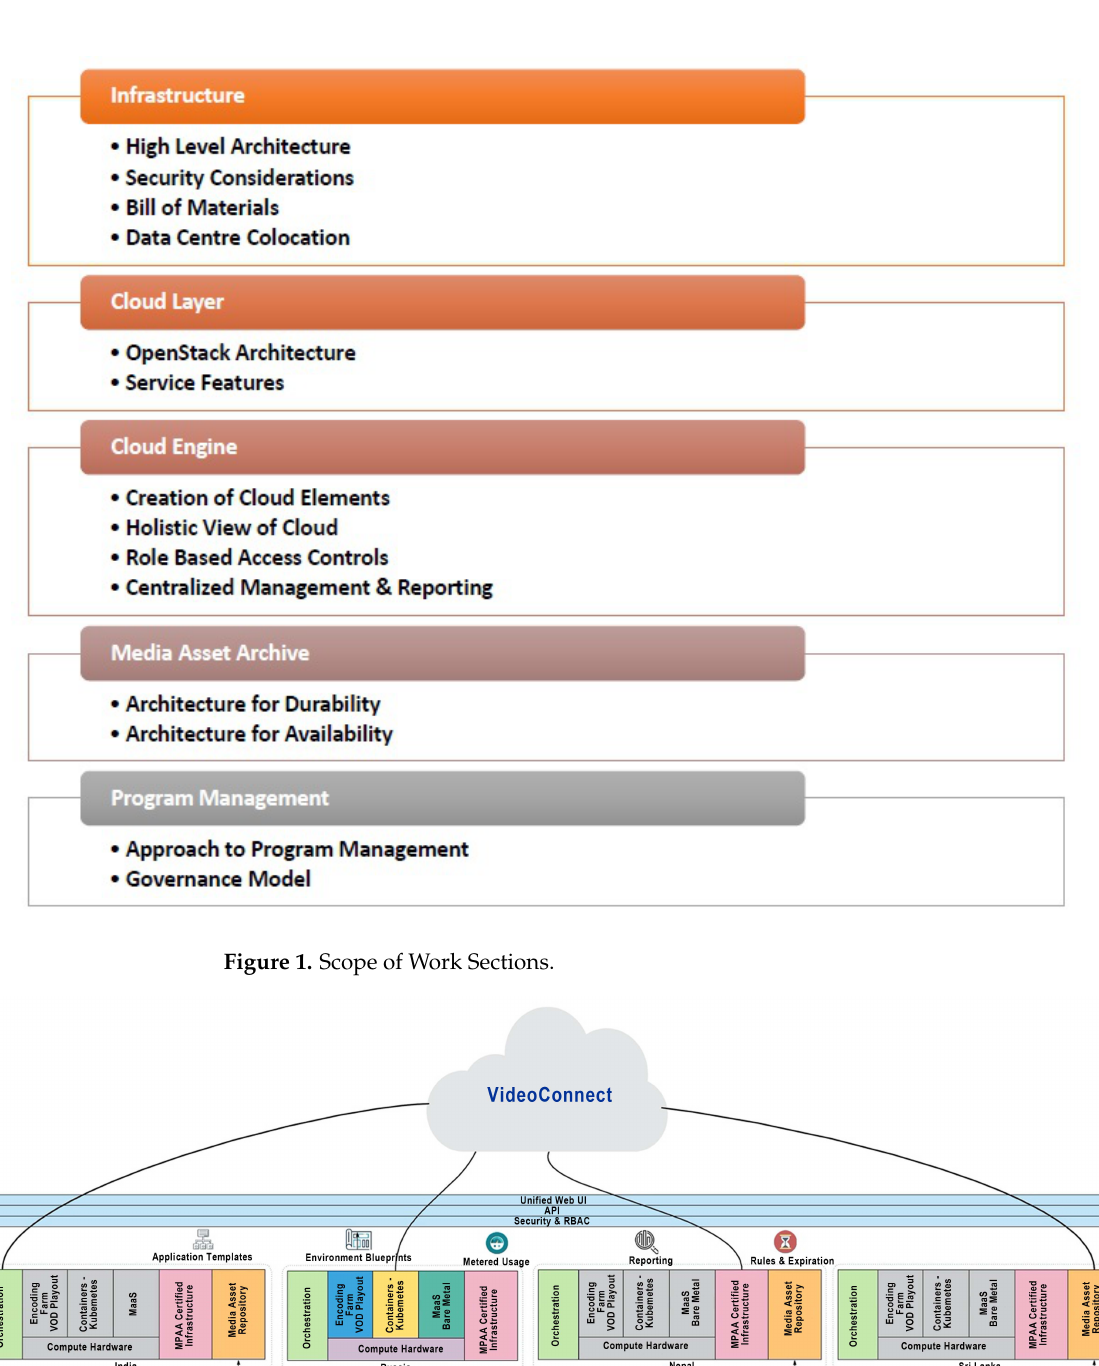
Figure 2. Global Media